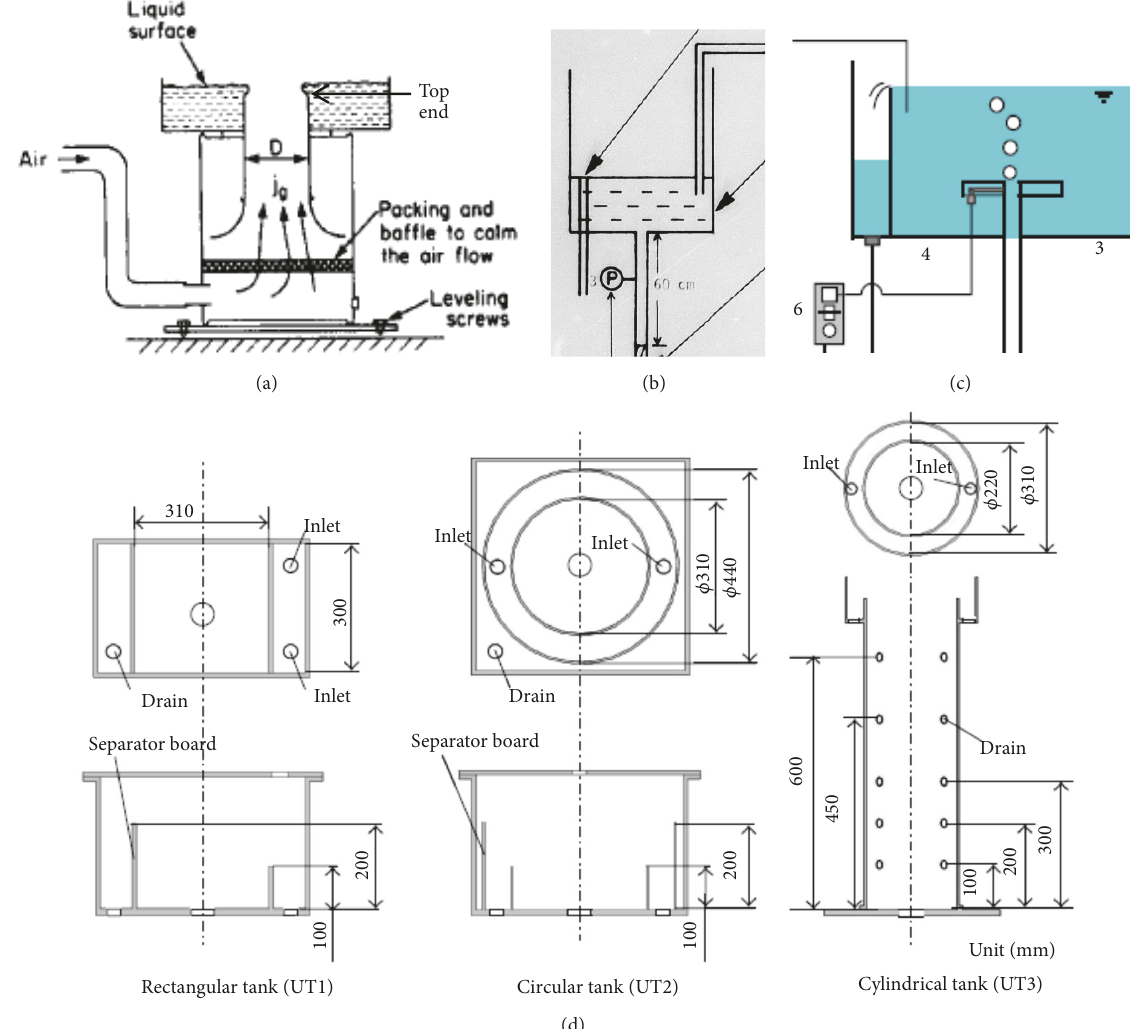
Figure 2: Shapes near the top end of the vertical pipe used by (a) Wallis and Kuo [11], (b) Bharathan et al. [12], (c) Matsumura and Kaminaga [13], and (d) Doi et al.